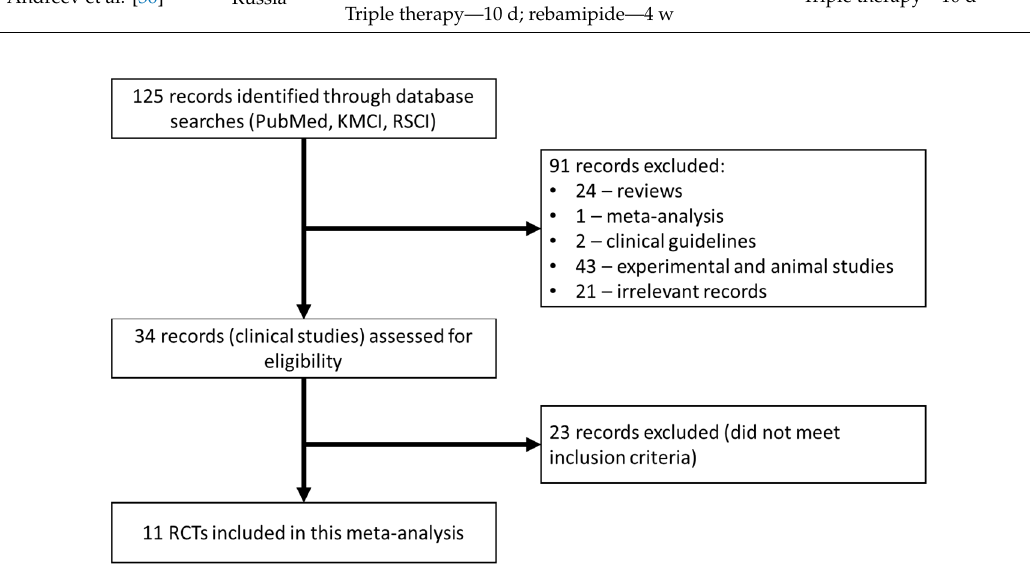
Figure 1. CONSORT chart detailing the study selection strategy.